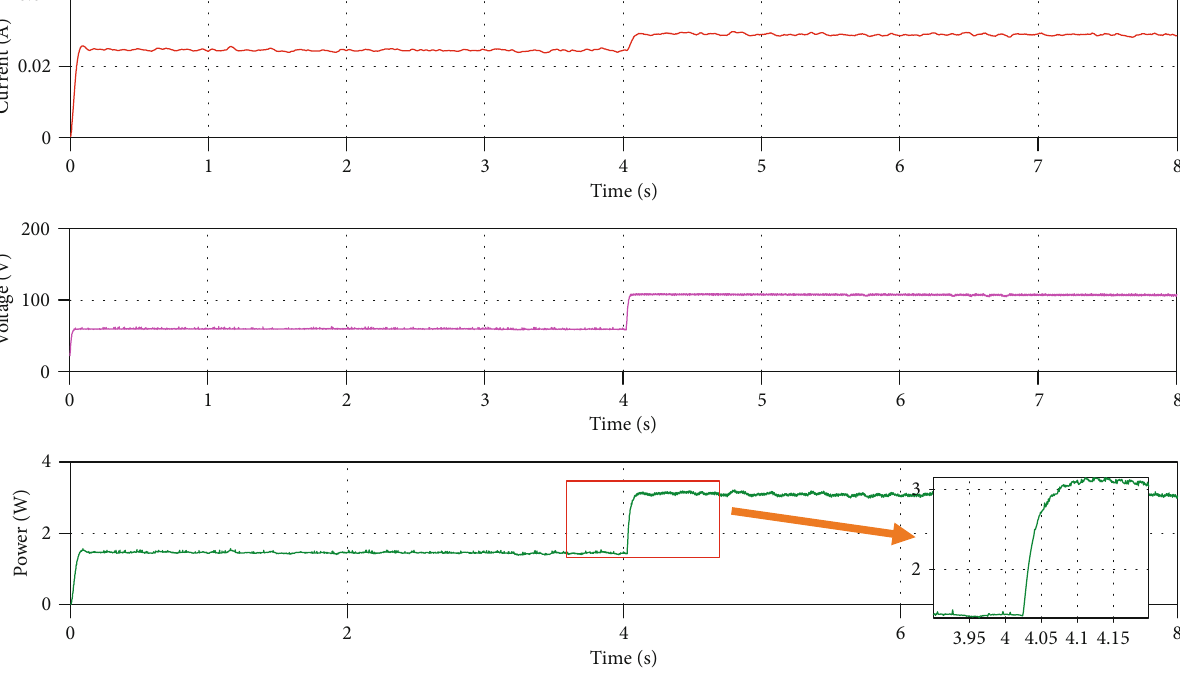
Figure 22: Experimental results (current, voltage, and power) of the modi fi ed MPPT controller during an irradiation